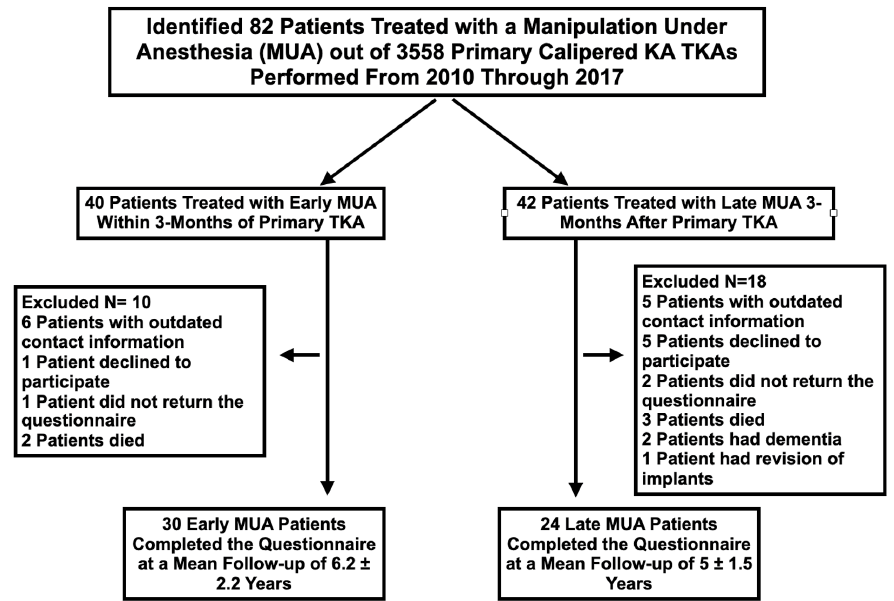
Figure 1. The CONSORT diagram shows, for the early and late groups, the number of patients assessed for eligibility, the number excluded with the specific reason, and the number that completed the